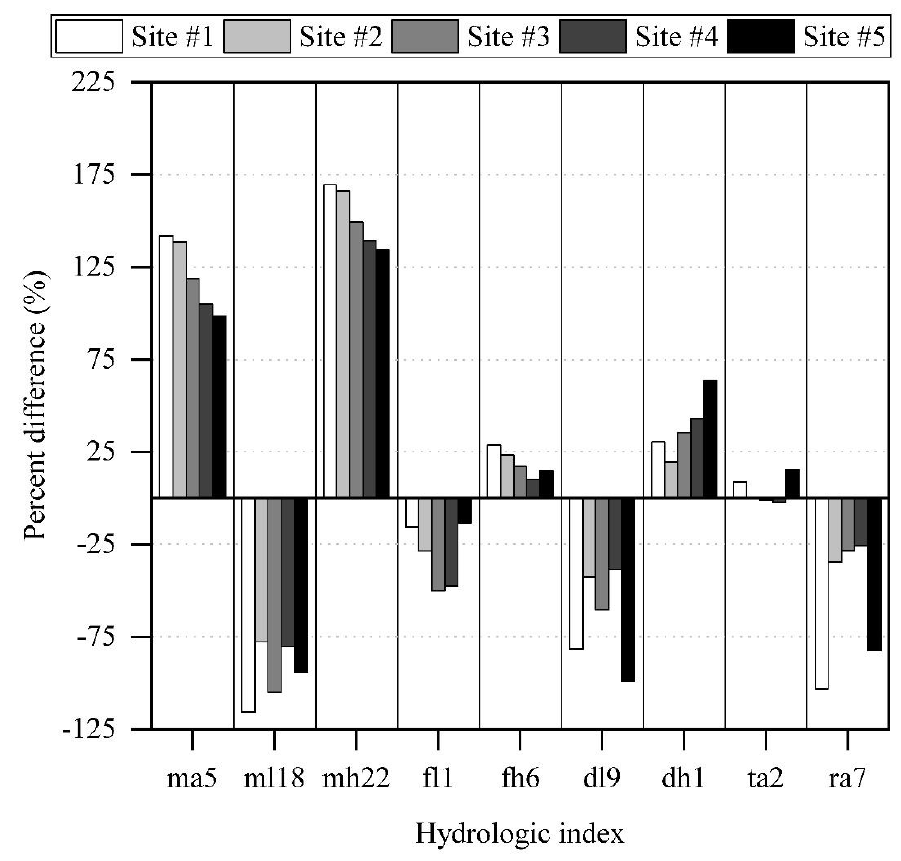
Figure 5. Percent differences between simulated pre-settlement and observed developed hydrologic indices at five gauging sites in Hinkson Creek, MO, USA. Definitions of hydrologic indices are shown in Table 2.